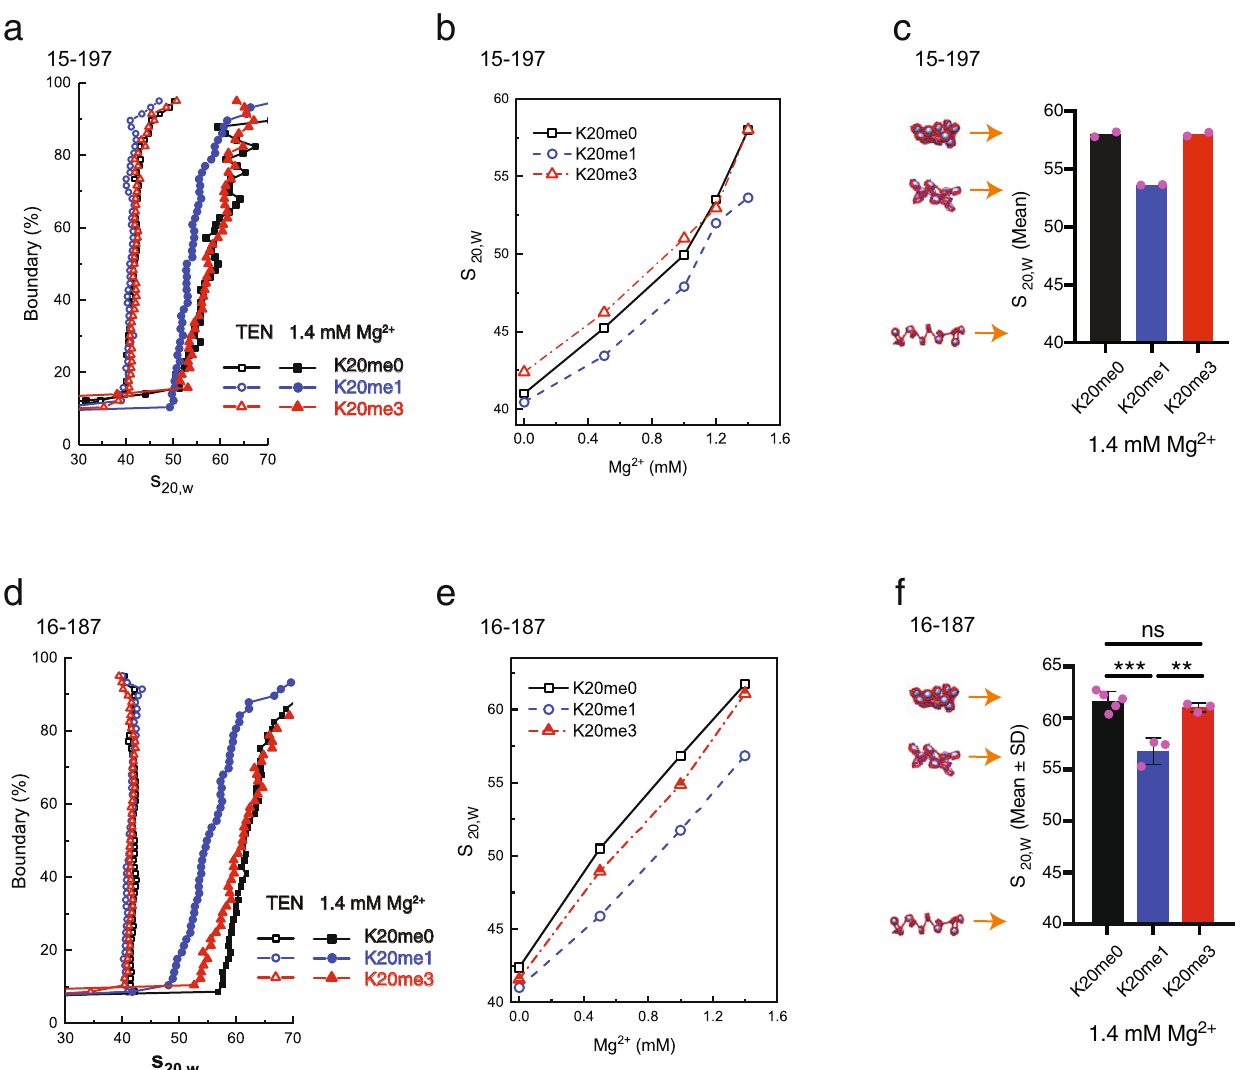
Fig. 5 Histone H4 lysine 20 mono-methylation results in unfolding of 15-197-601 and 16-187-601 nucleosome arrays. a , d van Holde – Weischet curves showing the boundary distribution curves for the 15-197 ( a ) and 16-187 nucleosome arrays ( d ) with the different methylated H4K20 histone constructs in the presence of 1.4 mM Mg 2 + . b , e AUC-SV titration curves for the 15-197 ( b ) and 16-187 arrays ( e ) in the presence of varying amount of Mg 2 + . Two or three independent sedimentation velocity measurements were performed for each array sample at varying salt concentration. The mean s20, w value was calculated from the s20, w obtained from the average of the values for 20 – 80% of the boundary curves (corresponding to the curves in a and d ). c , f Maximal folding of 15-197 ( c ) and 16-187 arrays ( f ) in the presence of 1.4 mM Mg 2 + for the three H4K20 methylation states. The baseline (at about s20, w = 40S) corresponds to the result in TEN buffer where the arrays adopt a “ beads-on-a-string ” extended conformation. Trimethylation (K20me3) has no effect on the maximal folding of arrays. The monomethylated array (K20me1) is unable to reach the maximal folding characterized by an s -value of 58S for 15-197 array and 61S for 16-187 array. One-way ANOVA analysis for different 16-197 arrays was shown (f). Data are presented as mean values + / − SD. ns not signi fi cant, p ≥ 0.05; **, 0.001 ≤ p < 0.01; ***, 0.0001 ≤ p < 0.001. For 16-187 array, n = 3 independent experiments for K20me1 and K20me3 arrays; n = 5 for K20me0 array; p = 0.0007 for me0 vs. me1, and p = 0.0056 for me1 vs. me3 ( f ). The representation of the arrays to the left in c and f schematically illustrates the degree of folding of the arrays. (See the Online Methods section for further details). Source data are provided as a Source Data fi (H4K20me0) arrays exhibited the behavior expected for an extended “ beads-on-a-string ” array conformation with a sedi- mentation coef fi cient (s 20,w ) ~ 41-42S for 197 as well as for 187 arrays (Fig. 5b, e). Upon addition of Mg 2 + , the H4K20me0 and H4K20me3 the 197 arrays folded gradually and fi nally reached the maximal degree of compaction at 1.4 mM Mg 2 + with a characteristic s 20,w ~58S. Remarkably, H4K20me1 exhibited an displaying an s 20,w value of ~53S at 1.4 mM Mg 2 + (Fig. 5b, c).